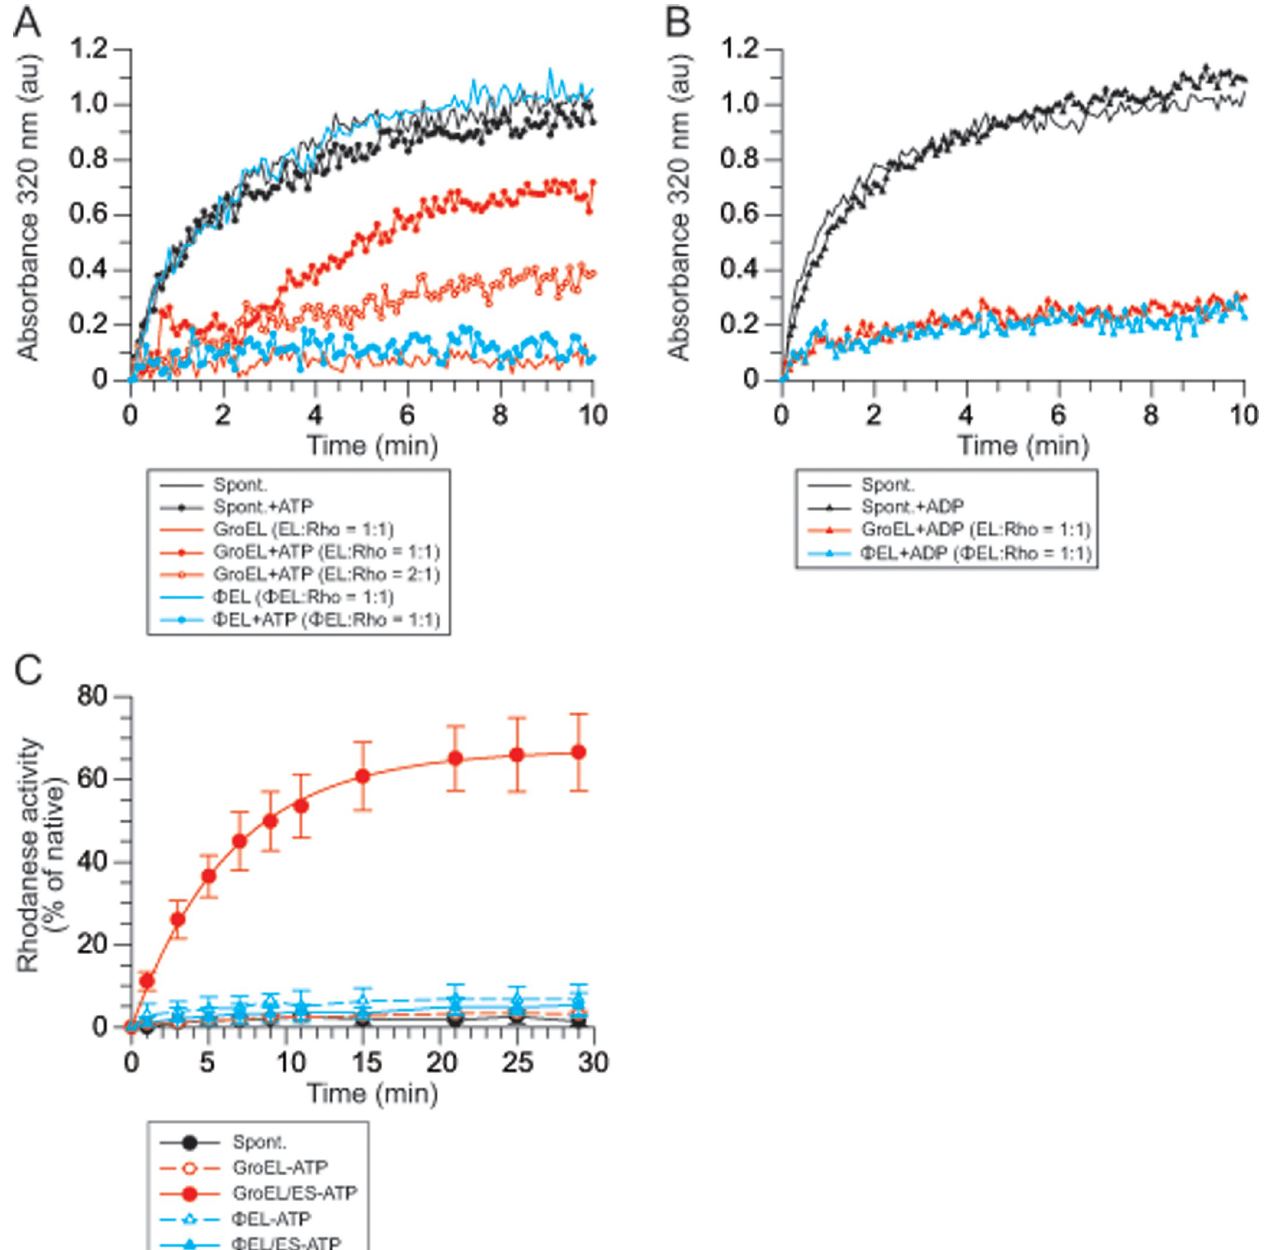
Fig 4. Molecular chaperone activity of ɸ EL. (A, B) Aggregation prevention activity of ɸ EL and GroEL in presence and absence of ATP (A) or ADP (B). Rhodanese (Rho) aggregation was monitored by turbidity assay at 320 nm wavelength. The results of representative experiments are shown. (C) Rho refolding in presence of ATP. The chaperones GroEL, GroES and ɸ EL were present when indicated. After quenching ATP hydrolysis by addition of CDTA at the indicated time points, Rho enzyme activity was determined. The averages from three experiments are shown, error bars indicate standard deviations.